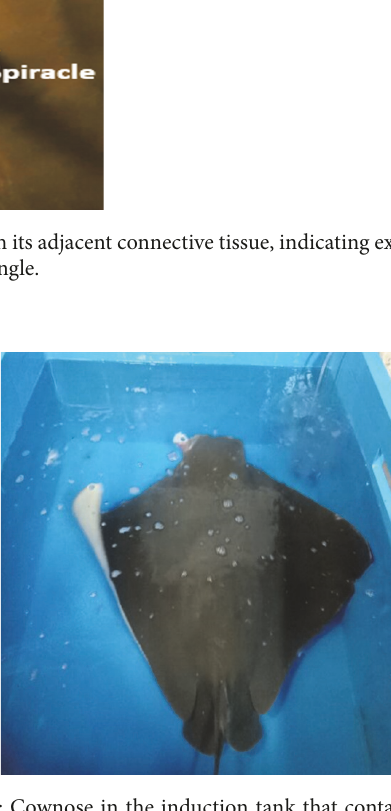
Figure 3: Cownose in the induction tank that contains 17ppm of